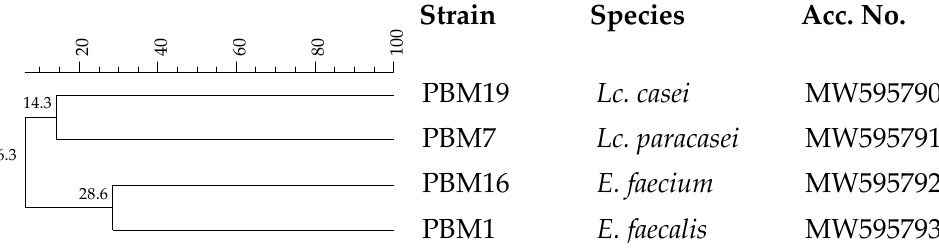
Figure 3. Dendrogram obtained with combined RAPD-PCR patterns generated with three primers for thermoduric indigenous milk LAB strains isolated from pasteurized milk. Abbreviations: E. , Enterococcus ; Lc. , Lacticaseibacillus .